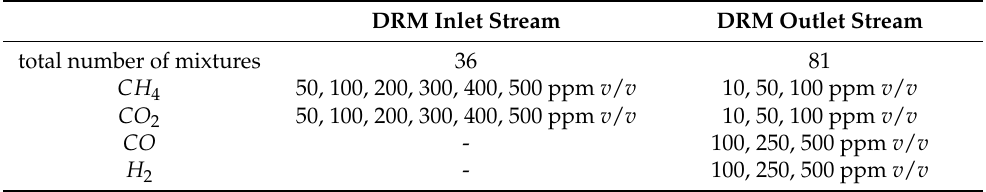
Table 5. Compositions of tested gas mixtures.